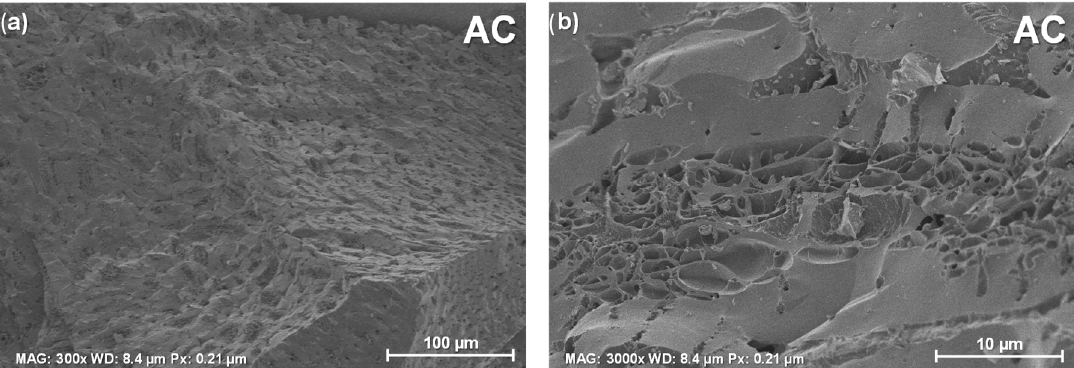
Figure 3. SEM images of the AC; ( a ) 300× and ( b ) 3000× magnification.